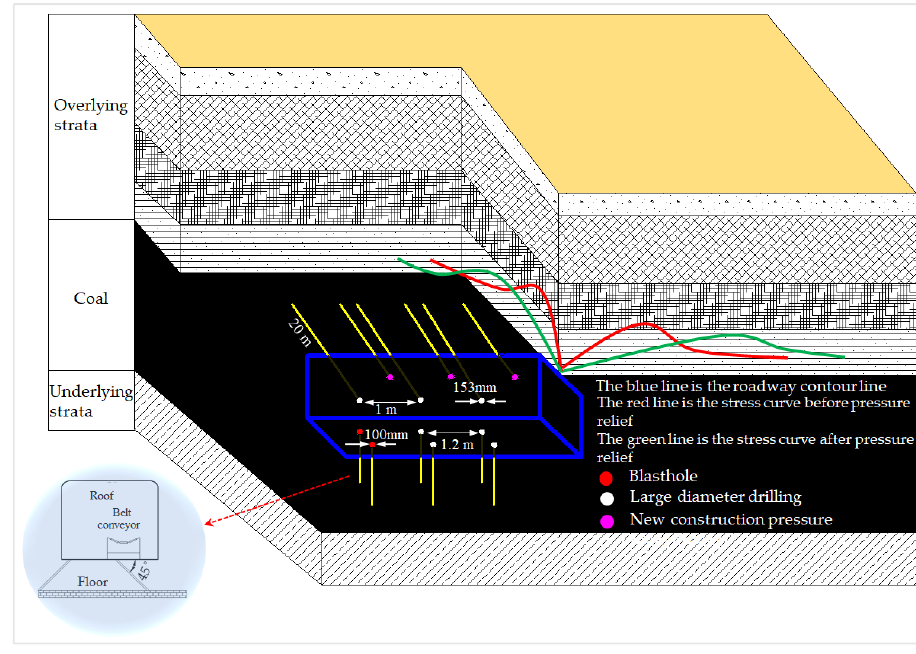
Figure 9. Layout Plan of Drill Holes at the Two Walls and Floor of Main Roadway.